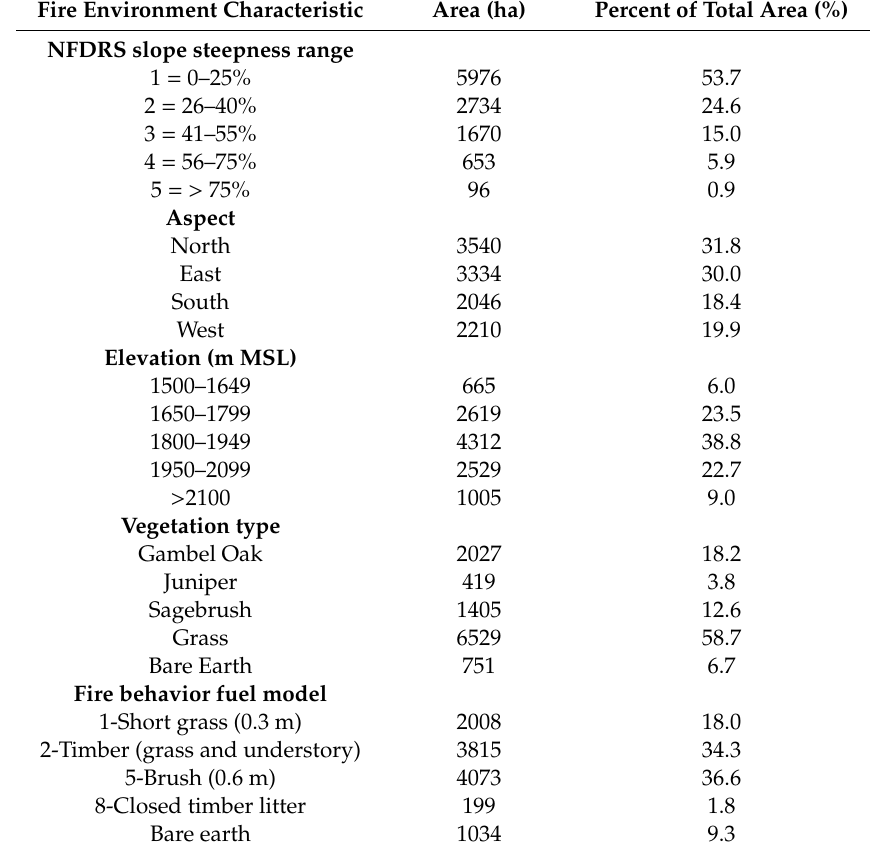
Table 5. Area estimates of topographic and fuel characteristics incorporating a 250 m bu ff er surrounding the Army Garrison Camp Williams